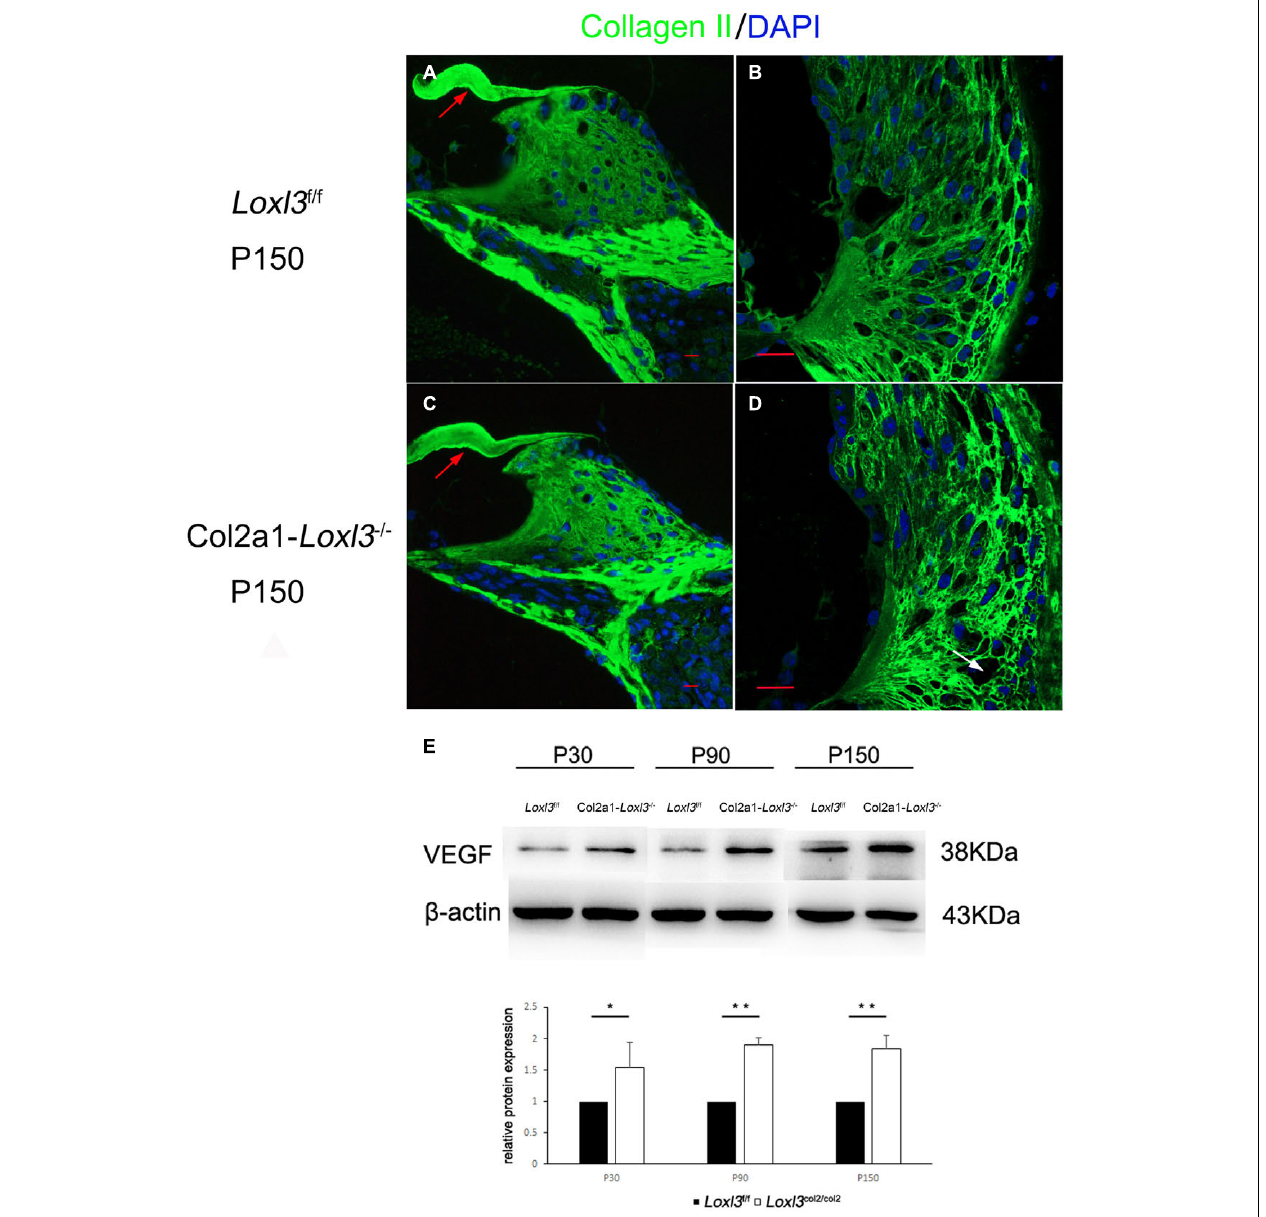
FIGURE 7 | Distribution of Type II collagen in the spiral ligament and the expression of vascular endothelial growth factor (VEGF) in the cochlea of Loxl3 f / f and Col2a1–Loxl3 − / − mice. (A , C) Representative image of type II collagen (green) immunofluorescence in the spiral limbus and the tectorial membrane of Loxl3 f / f and Col2a1–Loxl3 − / − mice at P150. The deposition of type II collagen was normal in the tectorial membrane of Col2a1–Loxl3 − / − mice than in those of Loxl3 f / f mice (red arrow). (B , D) Representative image of type II collagen (green) immunofluorescence in the spiral ligament of Loxl3 f / f and Col2a1–Loxl3 − / − mice at P150. The deposition of type II collagen was slightly abnormal in the spiral ligament of Col2a1–Loxl3 − / − mice than in those of Loxl3 f / f mice (white arrow). Scale bars: 20 µ m. (E) Western blot analysis of VEGF expression in the cochlea of Col2a1–Loxl3 − / − and Loxl3 f / f mice at P30–P150. The results of western blot analysis showed that the VEGF expression was significantly increased in the cochlea of Col2a1–Loxl3 − / − mice than in those of Loxl3 f / f mice at P30–P150 ( n = 5; * p < 0.05; ** p <